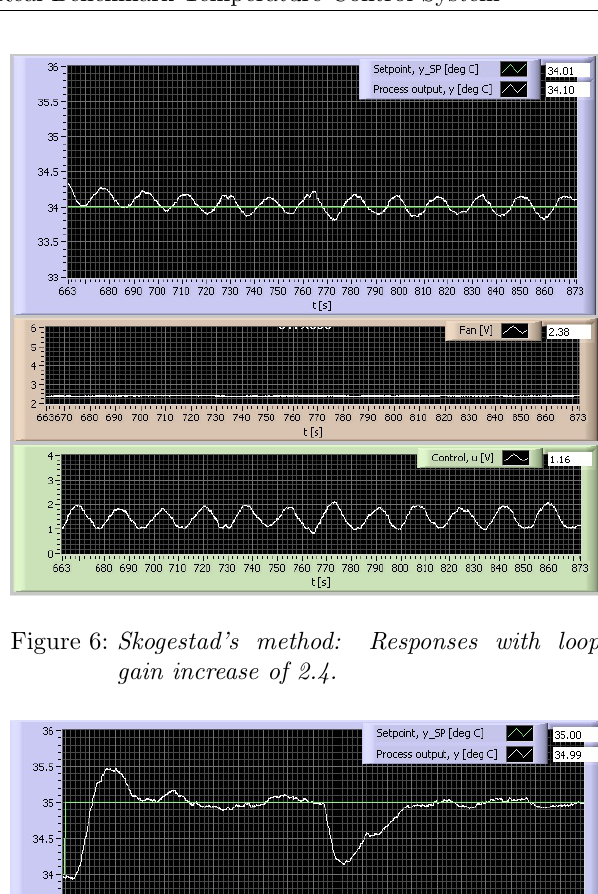
Figure 5: Skogestad’s method: Closed-loop responses. The IAE indices and the gain margin are IAE s = 12 . 5; IAE = 27 . 2; ∆ K = 2 . 4 = 7 . 6 dB (14) d